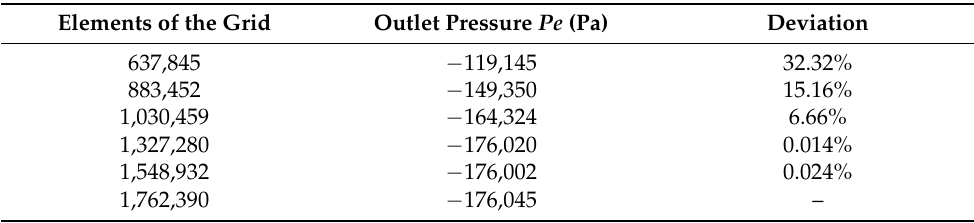
Table 2. Changes in the outlet pressure in different elements of the